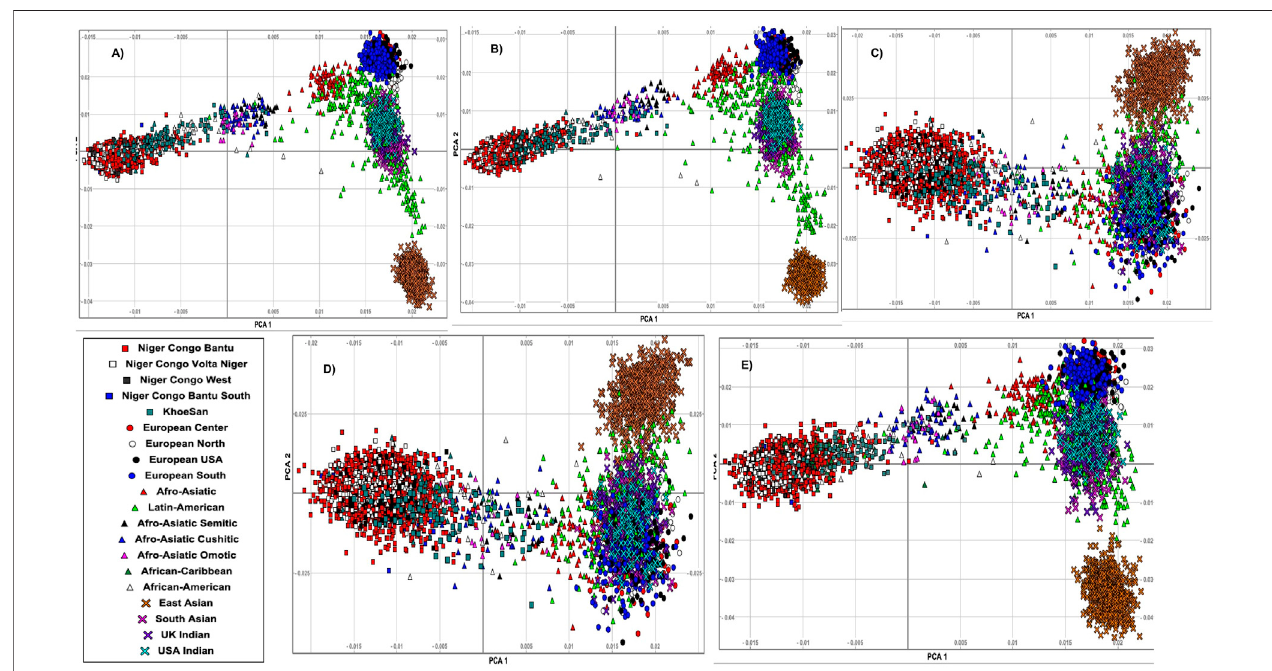
FIGURE1| Principalcomponentanalysis(PCA)ofgenesassociatedwith (A) HIV-speci fi c, (B) TB-speci fi c, (C) malaria-speci fi c, (D) sicklecelldisease-speci fi c,and (E) ACG-speci fi c SNPs and plots of the fi rst and second eigenvectors for 20 ethnolinguistic cultural groups.